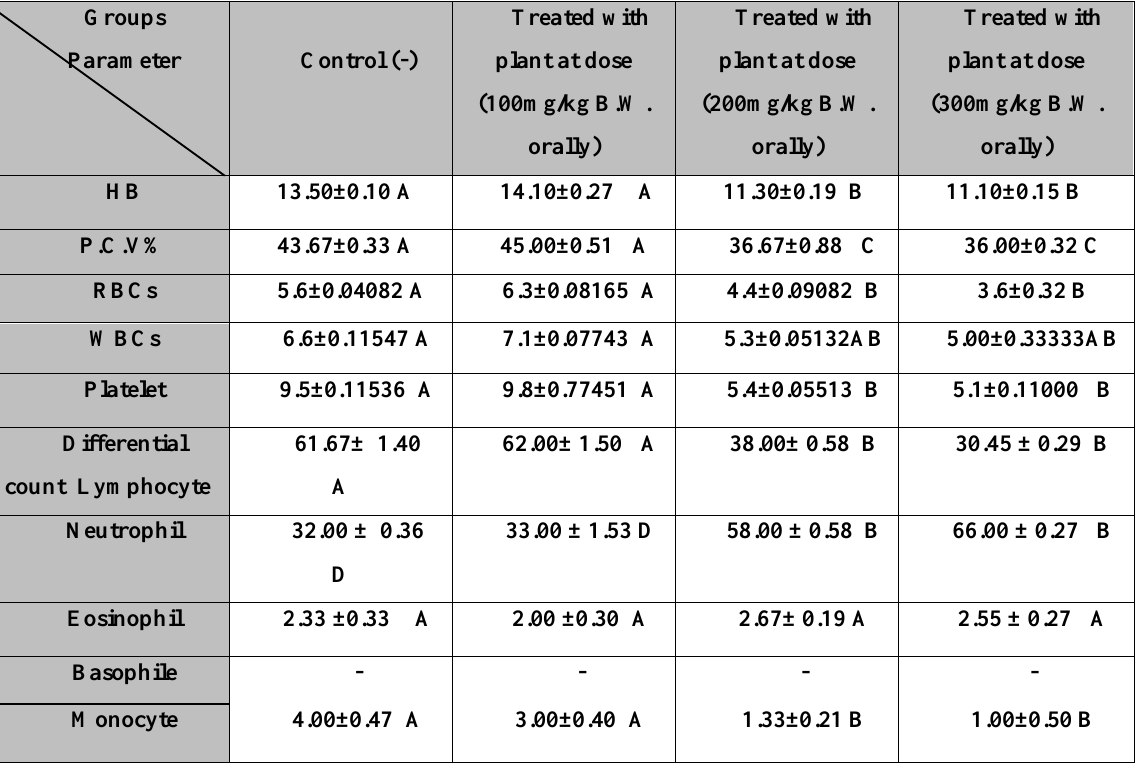
Basophile Monocyte 1.00±0.50 B Different letters means significant ( p <0.05) between